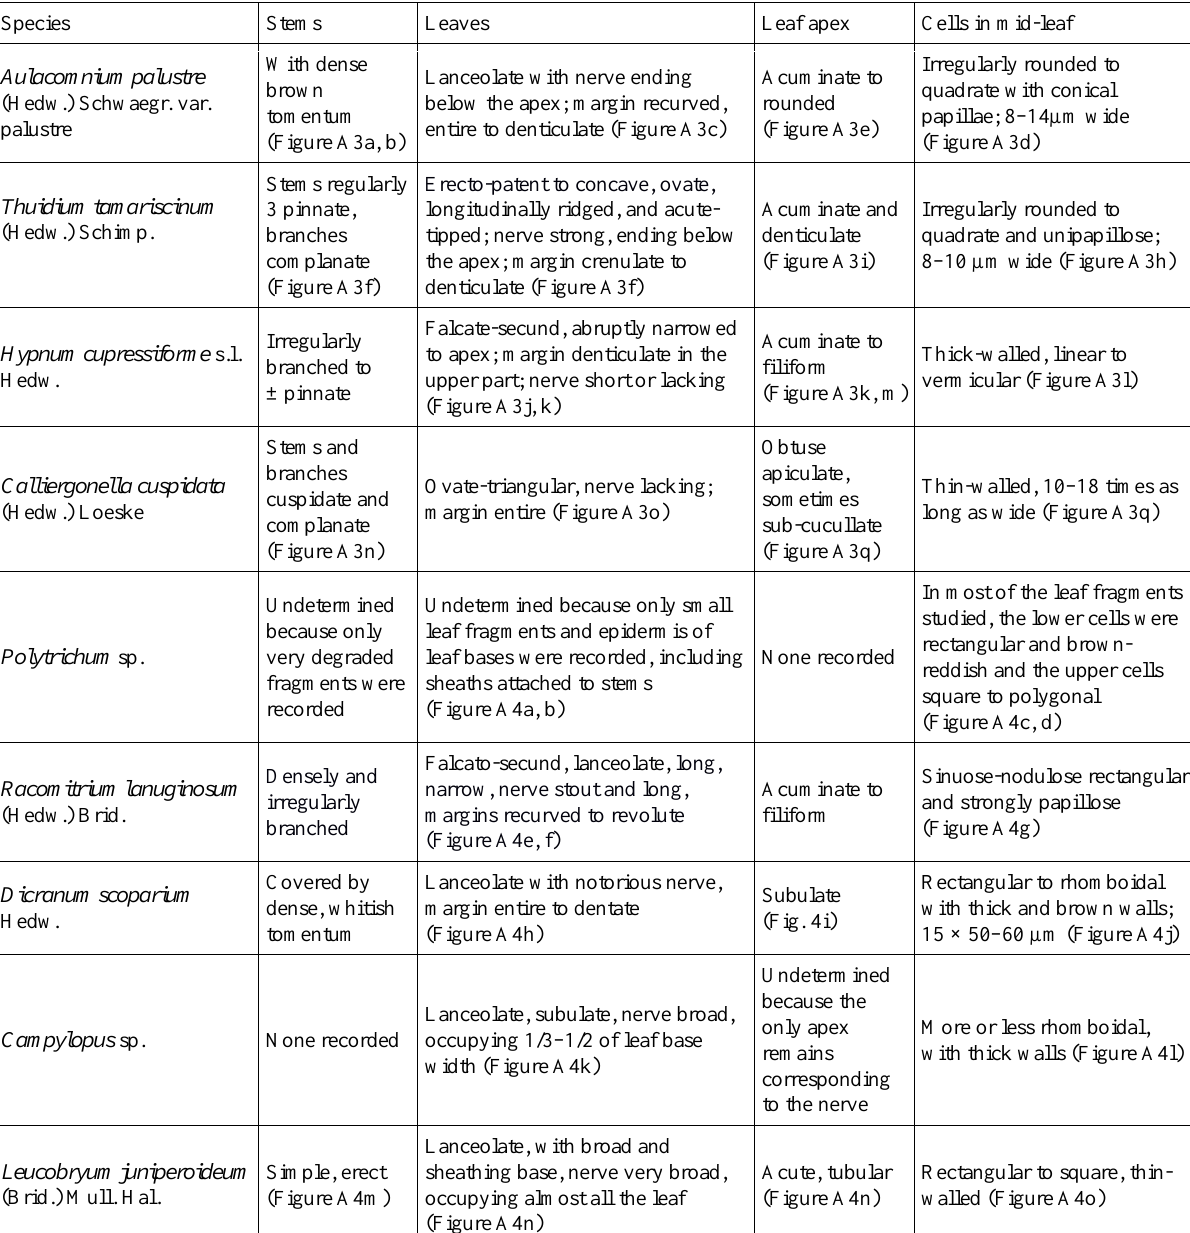
Table A3. Diagnostic characteristics for other mosses (Figures A3–4).